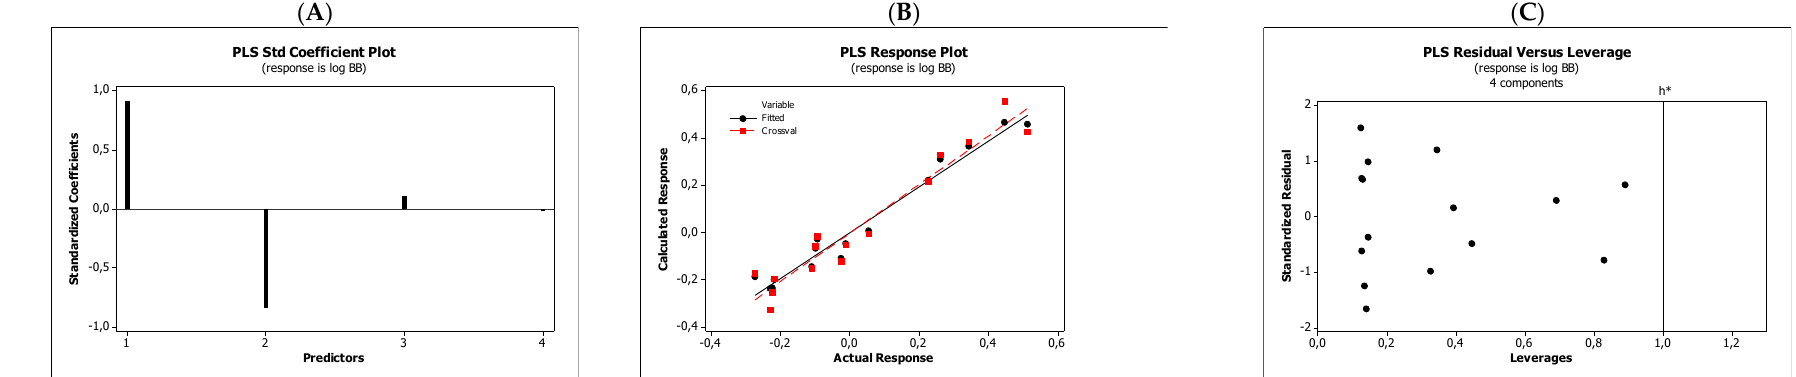
Figure 11. Standardized coefficients ( A ), the correlation between actual and predicted log BB parameters ( B ), and the Williams plots ( C ) of Equation (10).